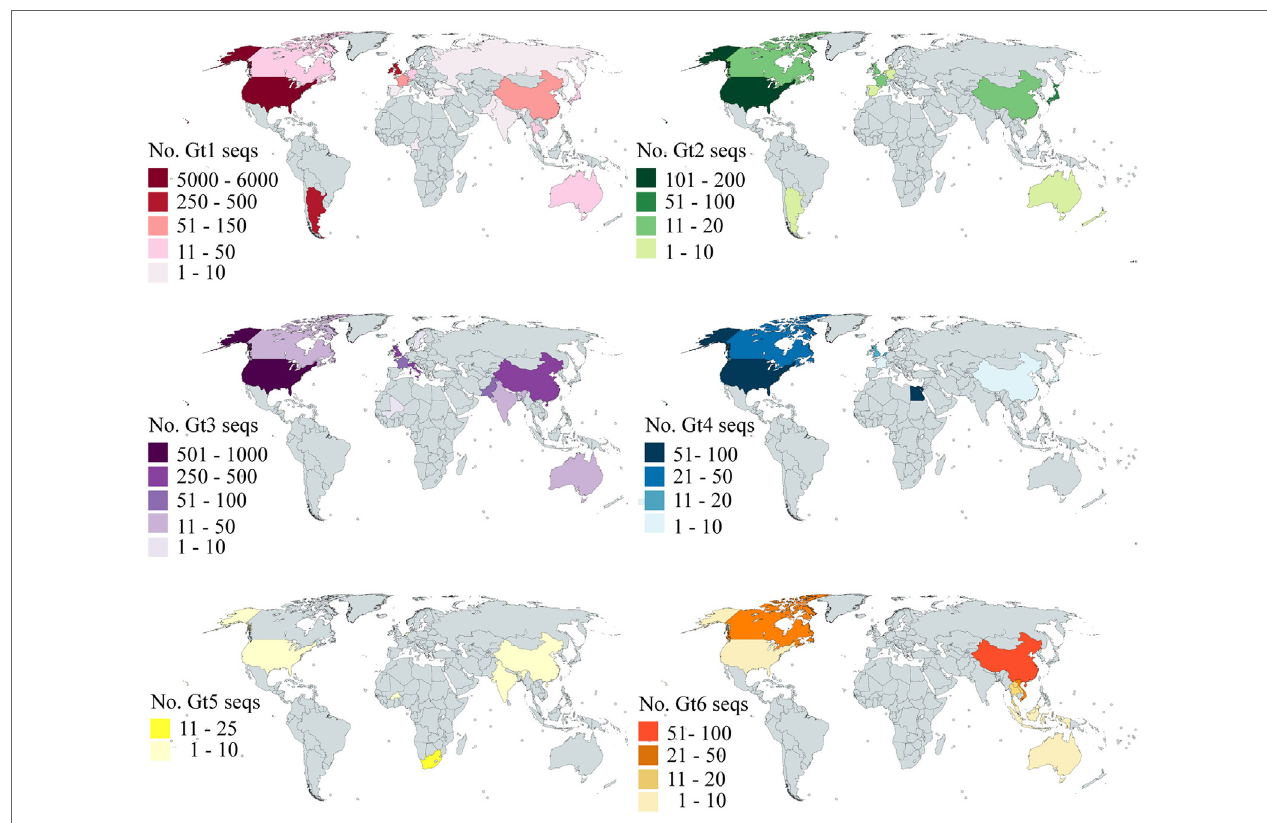
FigUre 5 | Global distribution of E2 sequence coverage. The maps are color-coded to show the number of E2 sequences (with at least 90% coverage) per country for Gt1 (red), Gt2 (green), Gt3 (purple), Gt4 (blue), Gt5 (yellow), and Gt6 (orange). Countries shaded in gray have no sequences